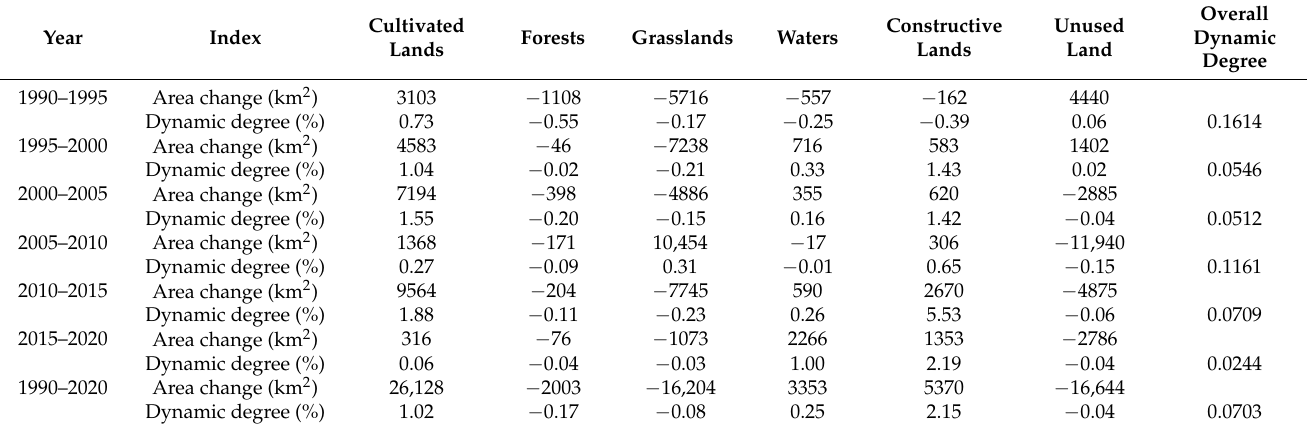
Table 3. Dynamic landscape changes in arid desert region of Northwest